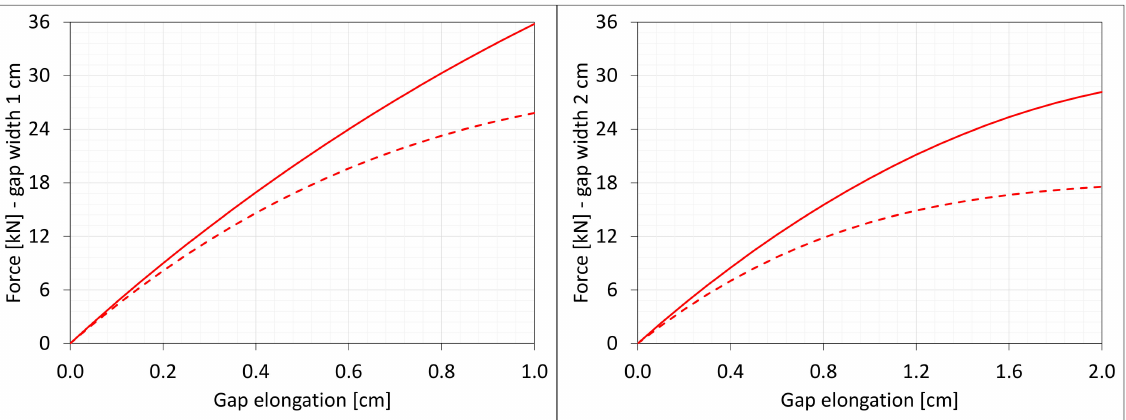
Figure 19. Equilibrium paths for excitation force N z . The width of the gap is equal to 1.0 cm, left graphic, and 2.0 cm, right graphic. Plane strain models, solid lines; and 3D models, dashed lines (curves from Figure